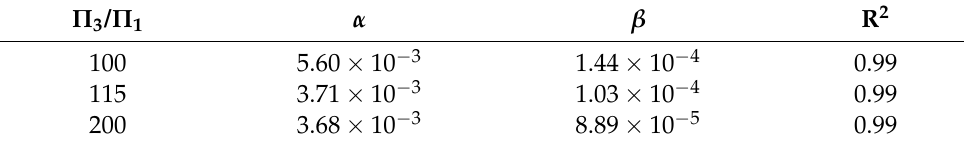
Table 4. Coefficients relating Π 0 to Π 2 .